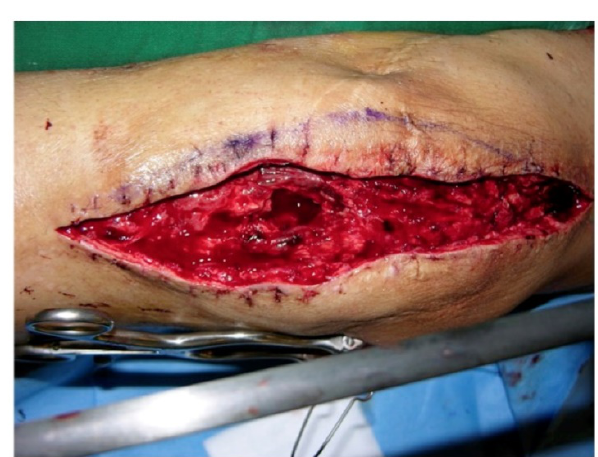
Figure 4: Total loss of the EA: Chronically infected TKA after several debridements, spacer implantation, and negative pressure wound therapy (NPWT) (Table 1: Patient No. 2).